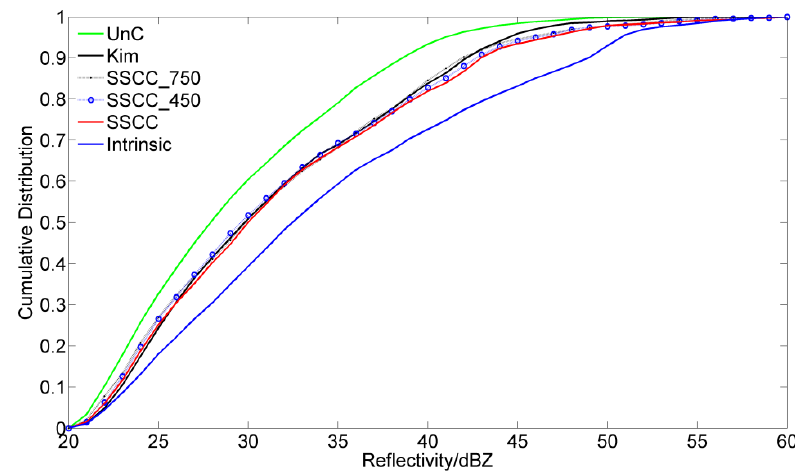
Figure 11. Cumulative distribution of reflectivity with different resolutions for the convective cloud.